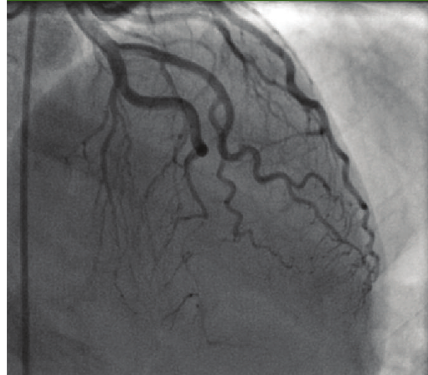
Figure 3: Cardiac catheterization after stent placement showing return of the blood flow in the LAD